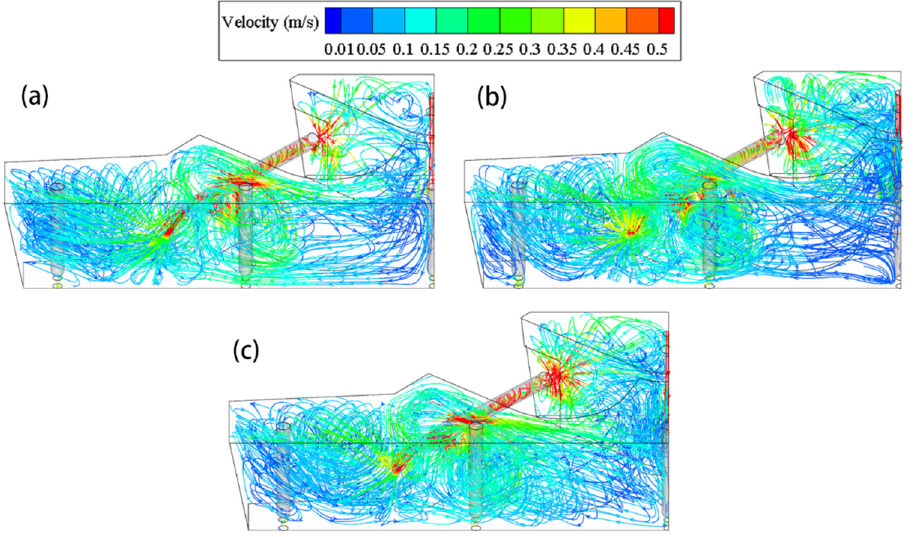
Figure 17. Three-dimensional (3D) streamline contour of three split channel schemes: ( a ) FK-A0; ( b ) FK-A5; ( c ) FK-A15.